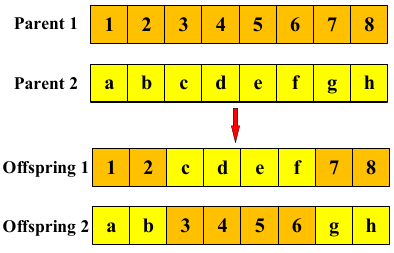
Figure 1. Two-point crossover diagram.